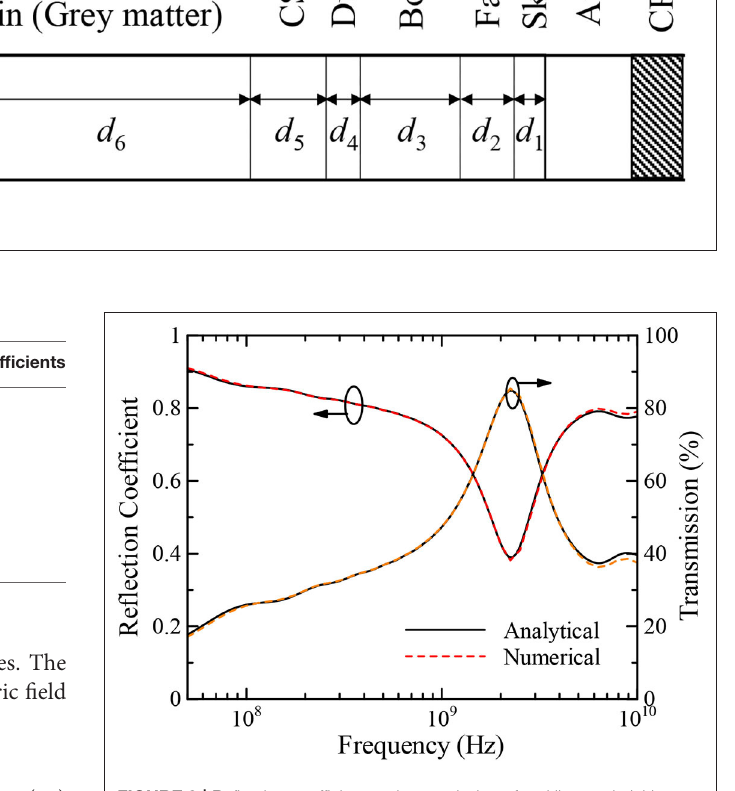
FIGURE 3 | Reflection coefficient and transmission of multilayer mimicking a human head